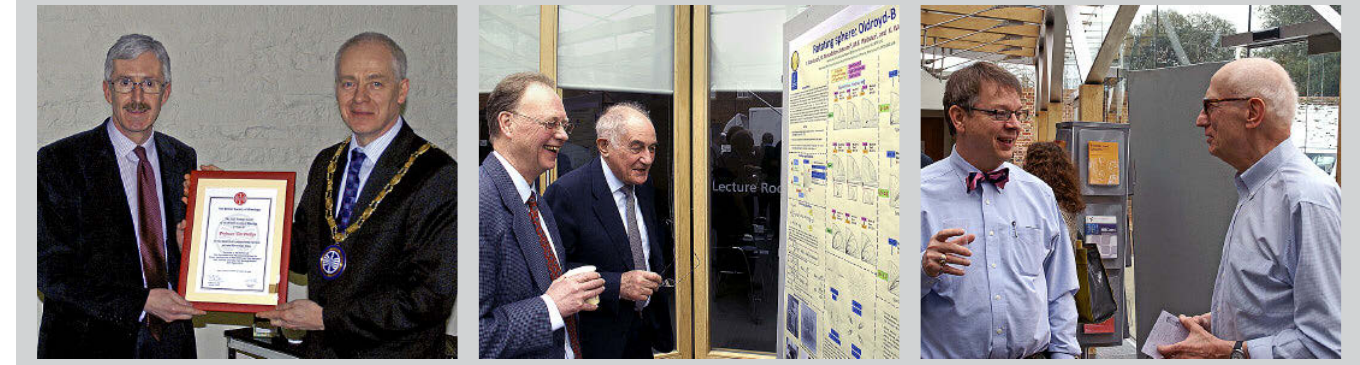
Figure 2 (left): Tim Phillips is being present- ed with the BSR Annual Award by chairman Bill Frith. Figure 3 (middle): Mike Webster with Marcel Crochet (I believe) in anoth- er picture. Figure 4 (right): Jeffrey Giacomin in conver-